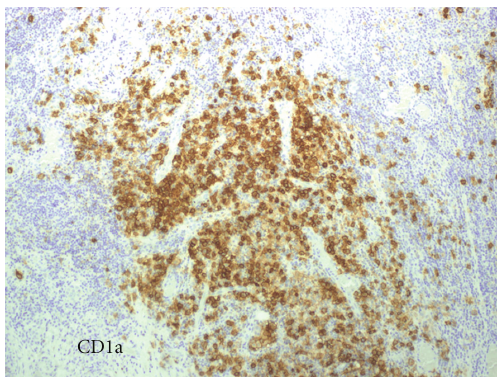
Figure 1: Focus of polymorph infiltrate and histiocytic negative for thyroglobulin. Normal positives thyroid cells peripherally.